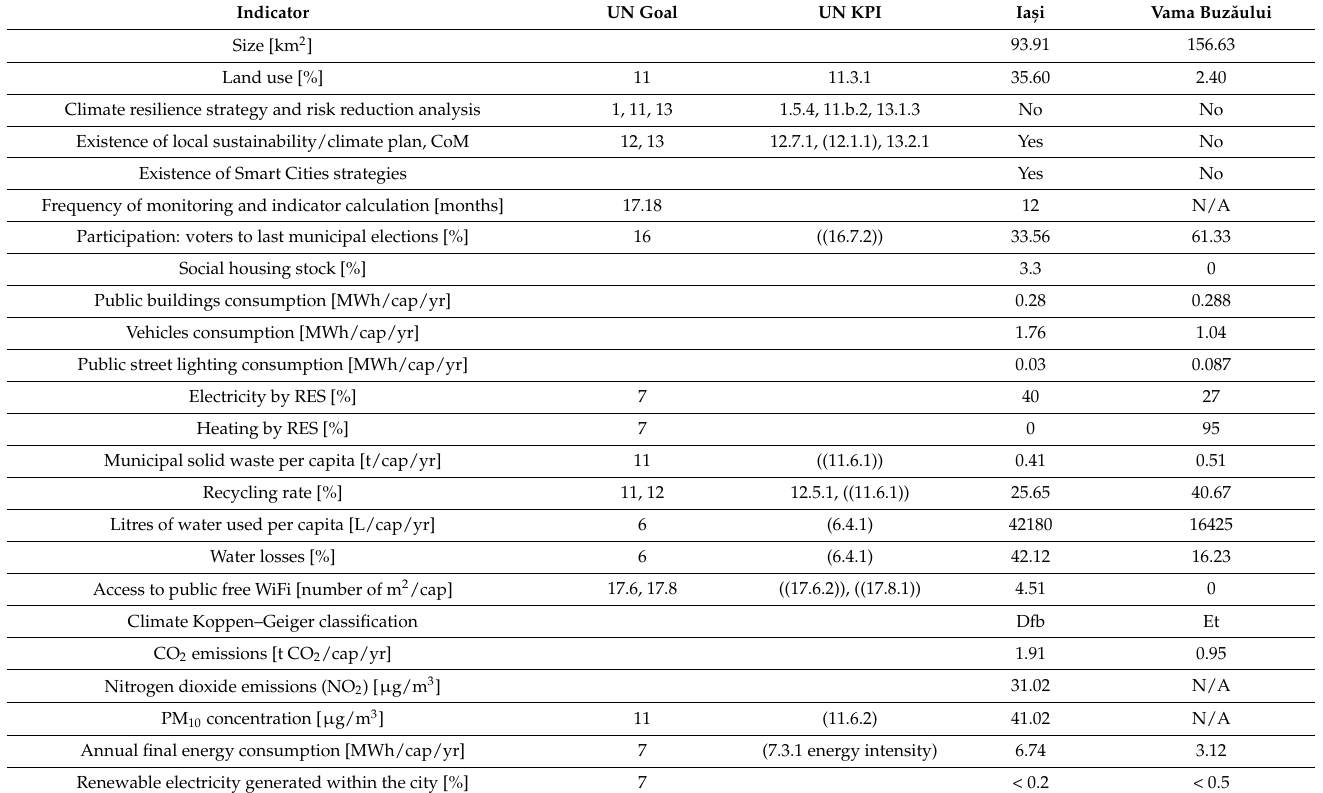
Table 1. Key performance indicators, connection to UN goals, and values for Ias